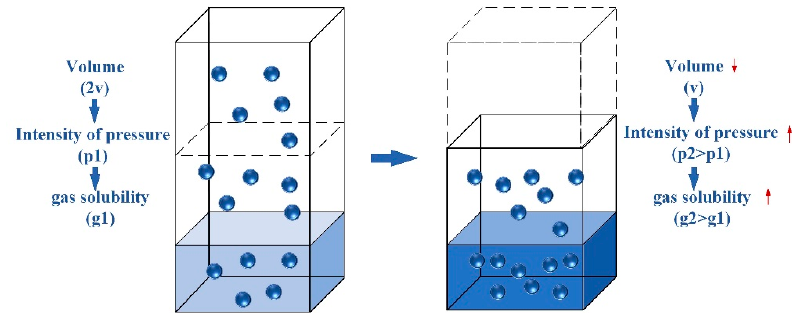
Figure 4. The relationship between the amount of dissolved gas particles and pressure.